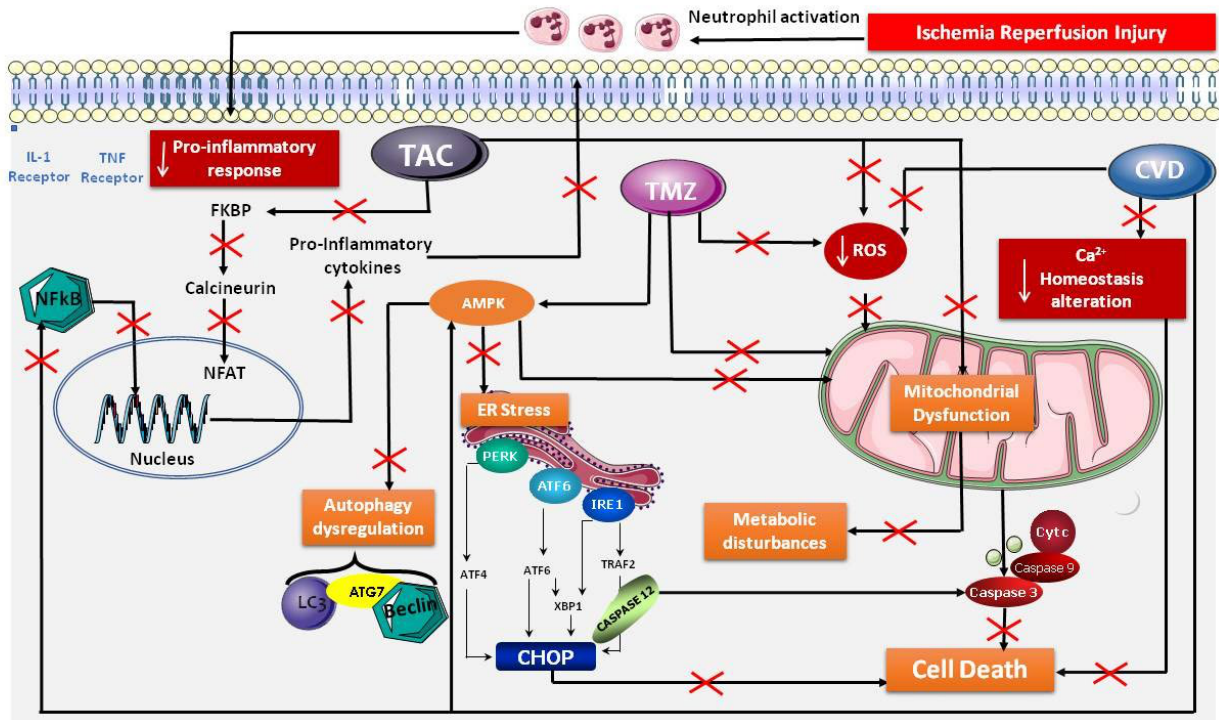
Figure 2. Schematic representation of the newly proposed signaling pathways of the specified drugs (trimetazidine, tacrolimus and carvedilol) in organ preservation aimed at regulating the mechanisms responsible for IRI. ↓ : decrease; ↑ : increase; AMPK: AMP-activated protein kinase; ATG7: autophagy-related gene 7; ATP: adenosine triphosphate; Ca 2+ : calcium ion; CHOP: C/EBP homologous protein; CVD: carvedilol; ER: endoplasmic reticulum; FKBP: FK506-binding protein; LC3B: light chain 3 B; NF-AT: nuclear factor of activated T-cells; NF- κ B: nuclear factor kappa-light-chain-en- hancer of activated B cells; NO: nitric oxide; PERK: protein kinase RNA-like ER kinase; ROS: reactive oxygen species; TAC: tacrolimus; TMZ: trimetazidine. 4. Conclusions Transplantation is a complex procedure that requires optimal conditions to ensure the long-term survival of the graft. The inevitable storage period between removal of the organ from the donor up to transplantation to the recipient generates an IRI. Current hypothermic solutions have their advantages and limitations. However, they all contain the same protective agents, which have not proven to be effective in protecting against IRI. Moreover, the increase in organs from extended criteria donors, which are more sen- sitive to IRI, combined with a better understanding of impacts of IRI, calls for an even better attention to preservation. Thus, the current main goal in the field of organ preservation is to define a formula- tion that includes new stable pharmacological components that protect against IRI with- out involving additional clinical risks. Trimetazidine, carvedilol and tacrolimus, which are safe multitarget drugs, seem to be good candidates for inclusion in the formulation of a new improved solution; they could be included into an optimal extracellular-type washing solution base, rich in sodium and with PEG as an oncotic agent. This strategy is about to move from today’s cold storage solution to tomorrow’s cold preservation solution. It will design a potential route towards optimized organ protection in transplantation.